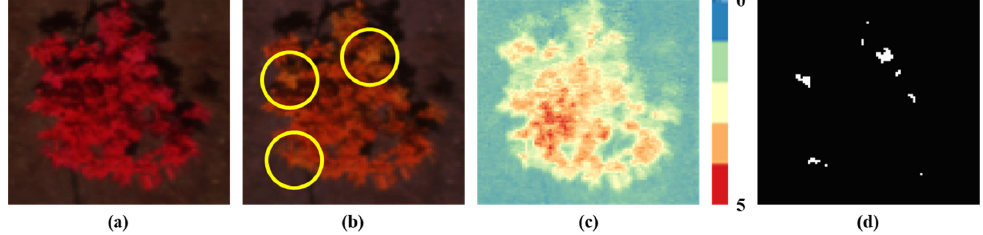
Figure 4. An individual tree in a multispectral orthomosaic image with di ff erent RGB color compositions: ( a ) conventional CIR (B: green, G: red and R: near-infrared (NIR)) and ( b ) RedEdge CIR (B: red, G: RedEdge and R: NIR). Flush cluster pixels show di ff erent colors from older leaves (yellow circles). Based on the threshold ranges, ( d ) flush cluster pixels were extracted from the ( c ) CI map.